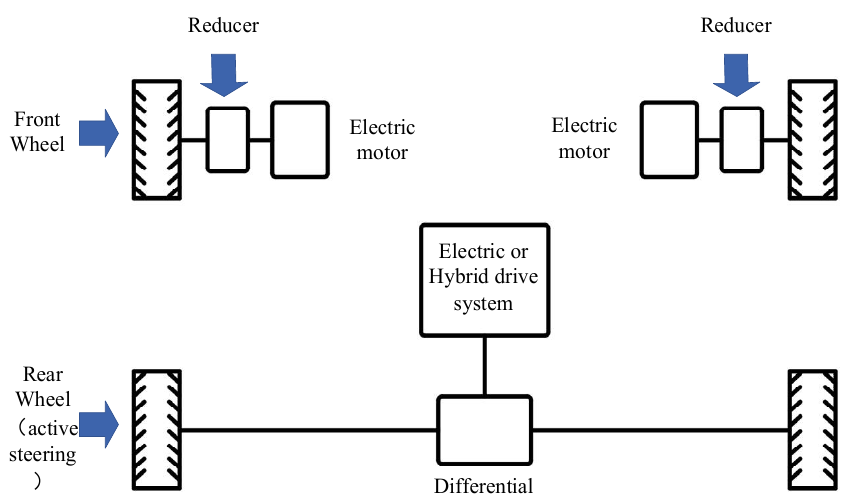
Figure 7. The layout structure of the power system of an all-wheel-steer distributed-drive new energy vehicle.